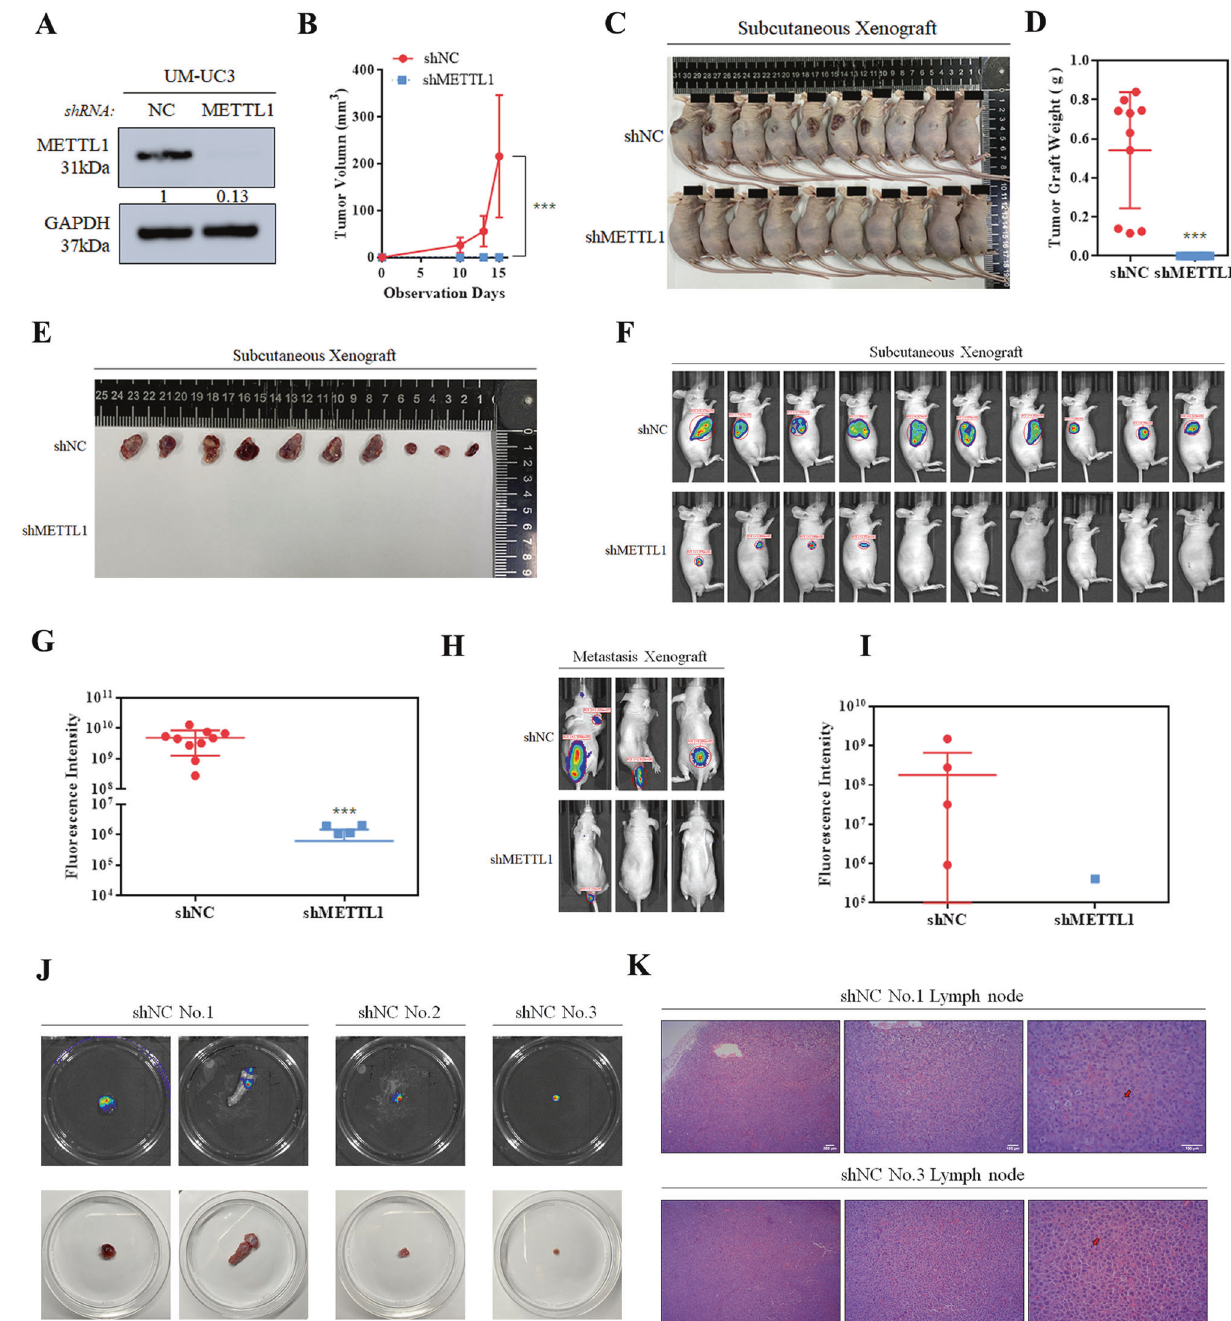
Fig. 3 METTL1 is demanded for tumor proliferation and metastasis of BCa in vivo. A Western blot assay showed METTL1 was deleted by shMETTL1. GAPDH was used for the normalization control. B – G Subcutaneous xenograft tumor model (BALB/c nude mice). B The tumor growth curve of subcutaneous xenografts plotted by the tumor size (width 2 × length × 0.52) measured with vernier caliper every 3 days ( n = 10 each group). C – E Subcutaneous xenografts in METTL1 depletion group grew too slow to be fi gured out by the naked eyes at end point of observation. F – J Fluorescence intensity measured by IVIS system was weaker in shMETTL1 group than shNC group. H – K Experimental metastases mice model (BALB/c nude mice) by caudal vein injection. H , I Fluorescence intensity of and the amount of metastasis sites measured by IVIS system decreased in shMETTL1 group. J Lymph node metastases and osseous metastases obtained from shNC group. K H&E staining of lymph node metastases. The red arrows point to abnormal cells with pathologic mitosis. Statistical signi fi cance was determined by Student ’ s t test: *** P < mechanism of METTL1 in BCa. We summarized a regulatory axis that METTL1 promoted the processing of miR-760 by m 7 G modi fi cation to accelerate the degradation of ATF3, which made a progression of proliferation and migration in BCa (Fig. 7).